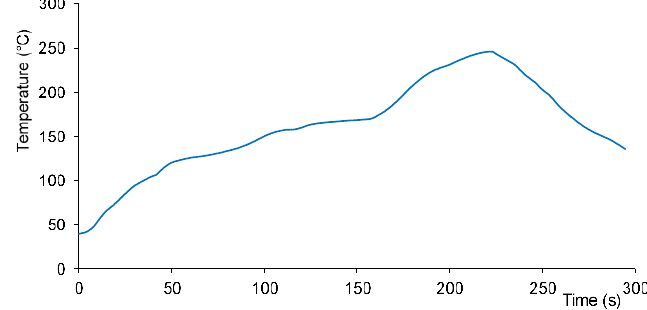
Figure 1. Used temperature profile of reflow oven Mistral 260.